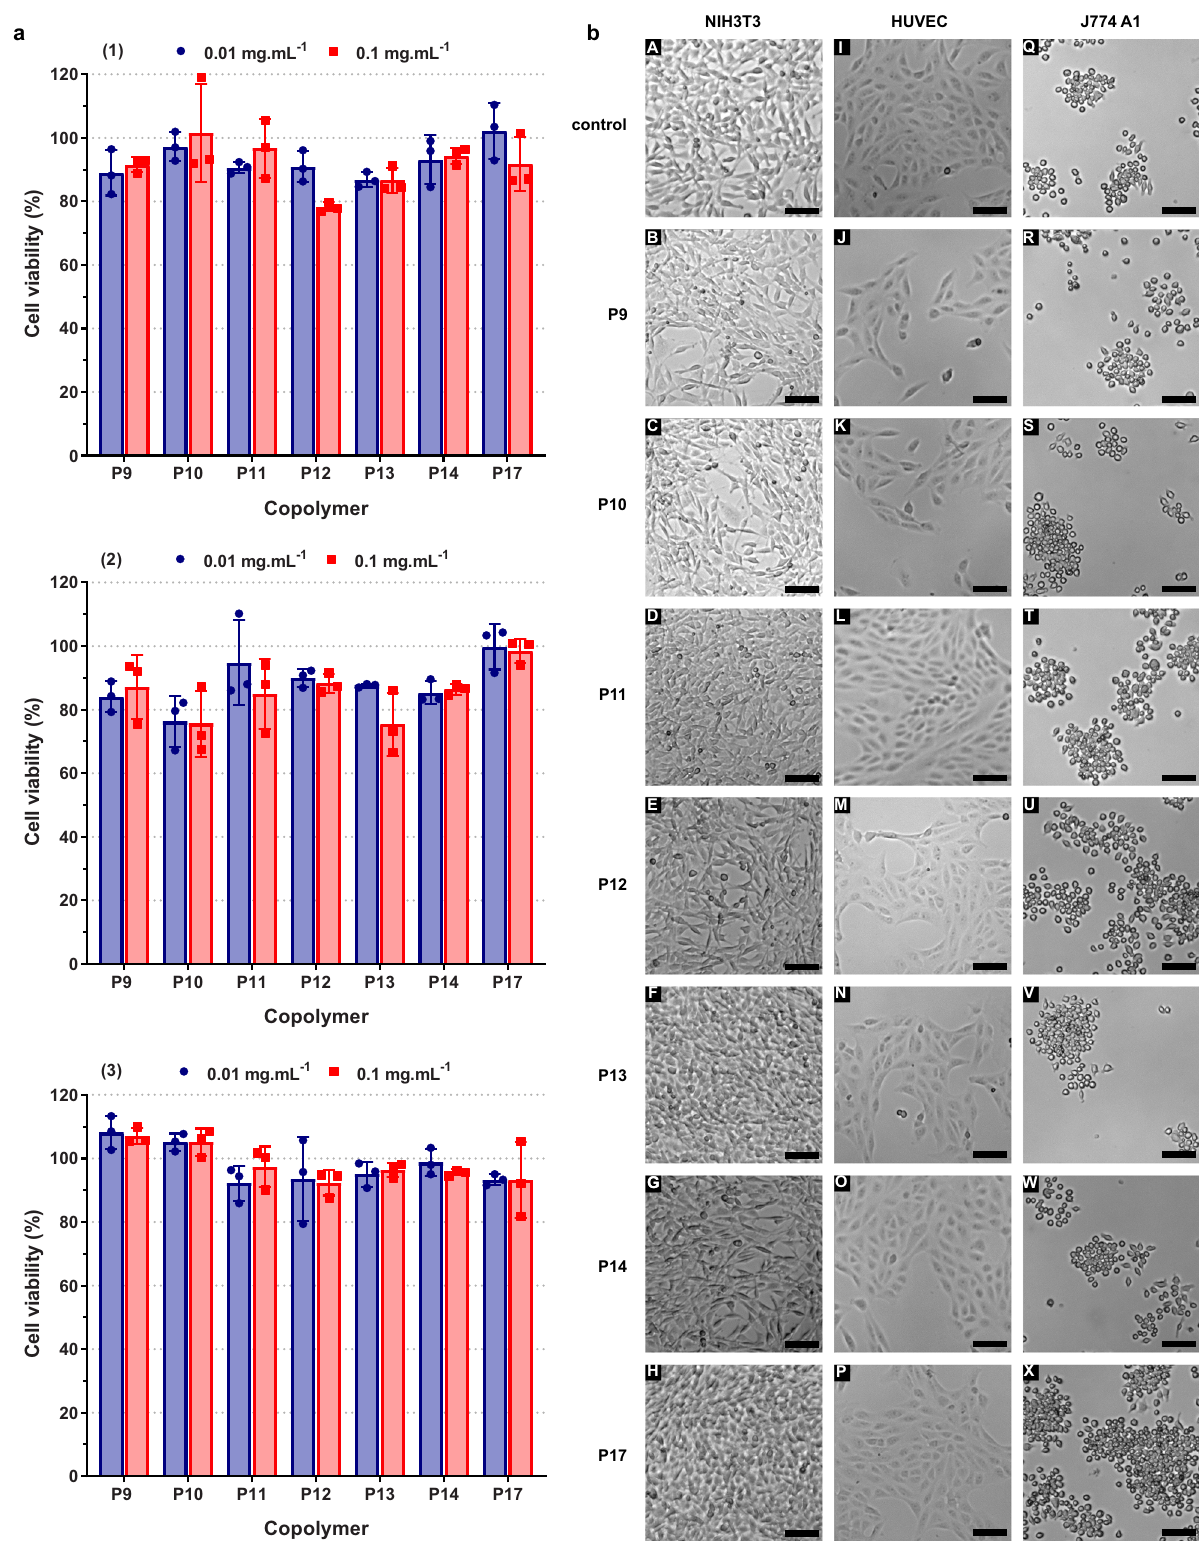
Fig. 7 Cytocompatibility of P(AAm- co -BMDO) copolymers. a Cell viability (MTT assay) after incubation of: (1) NIH/3T3 cells; (2) HUVEC cells; and (3) J774.A1 cells with P(AAm- co -BMDO) copolymers as function of the BMDO content ( P9 – P14 and P17 , Table 2) at 0.01 and 0.1 mg mL − 1 . Results were expressed as the percentage of absorption of treated cells ( n = 3 for each condition, error bars represent mean ± SD) in comparison with the values obtained from untreated control cells; b optical images of NIH/3T3 cells ( fi rst column, a – h ), HUVEC cells (second column, I – P) and J774.A1 cells (third column, Q – X) taken by optical microscopy after treatment for 72 h with P(AAm- co -BMDO) copolymers (0.1 mg mL − 1 ): Line 1: untreated cells; line 2: P9 ; line 3: P10 ; line 4: P11 ; line 5: P12 ; line 6: P13 ; line 7: P14; line 8: P17 . Scale bar = 100 μ